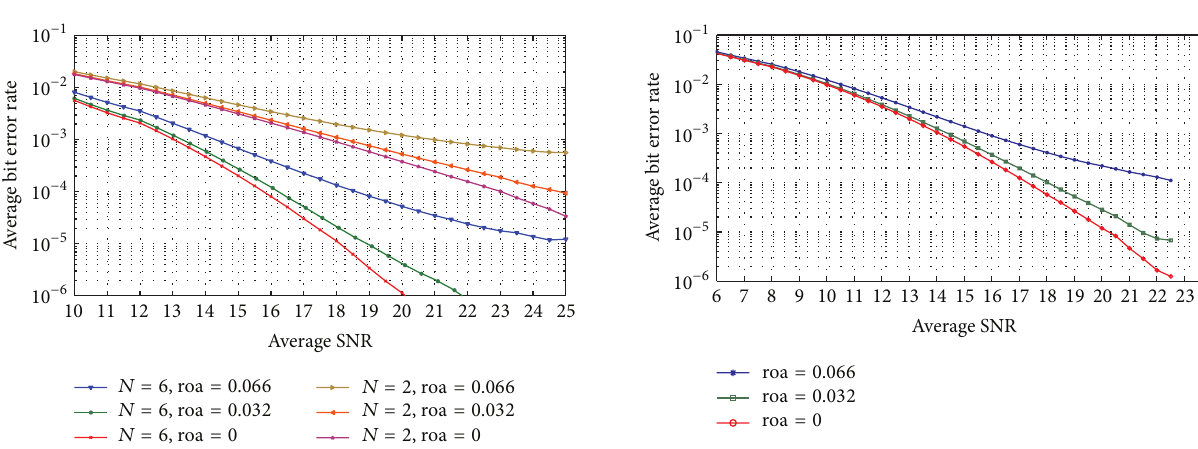
Figure 7: The average probability of bit error of code-time diversity system in Rayleigh flat fading channel with 𝑁 = 2, 6 using orthogo- nal and nonorthogonal spreading codes.